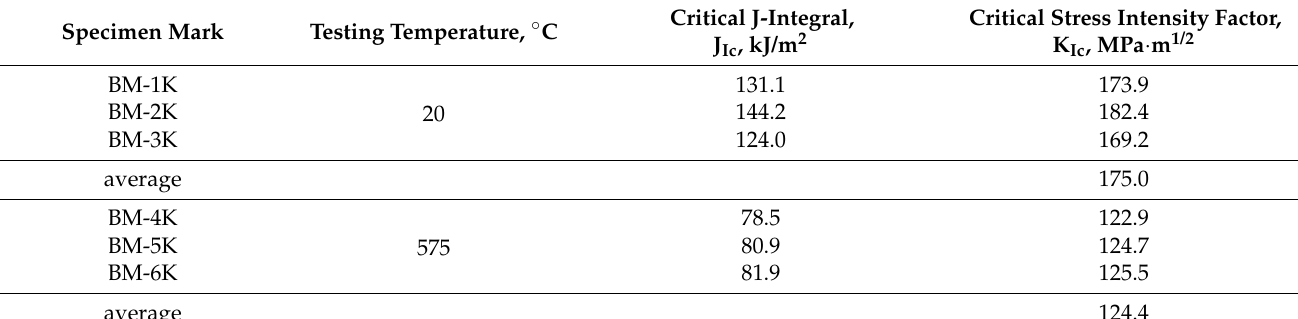
Figure 12. The J ‐ R curve and J Ic evaluation for SA 387 Gr. 91—WM at ( a ) 20 °C, ( b ) 575 °C. Figure 12. The J-R curve and J Ic evaluation for SA 387 Gr. 91—WM at ( a ) 20 Table 10. K Ic values obtained via J Ic for SA 387 Gr.